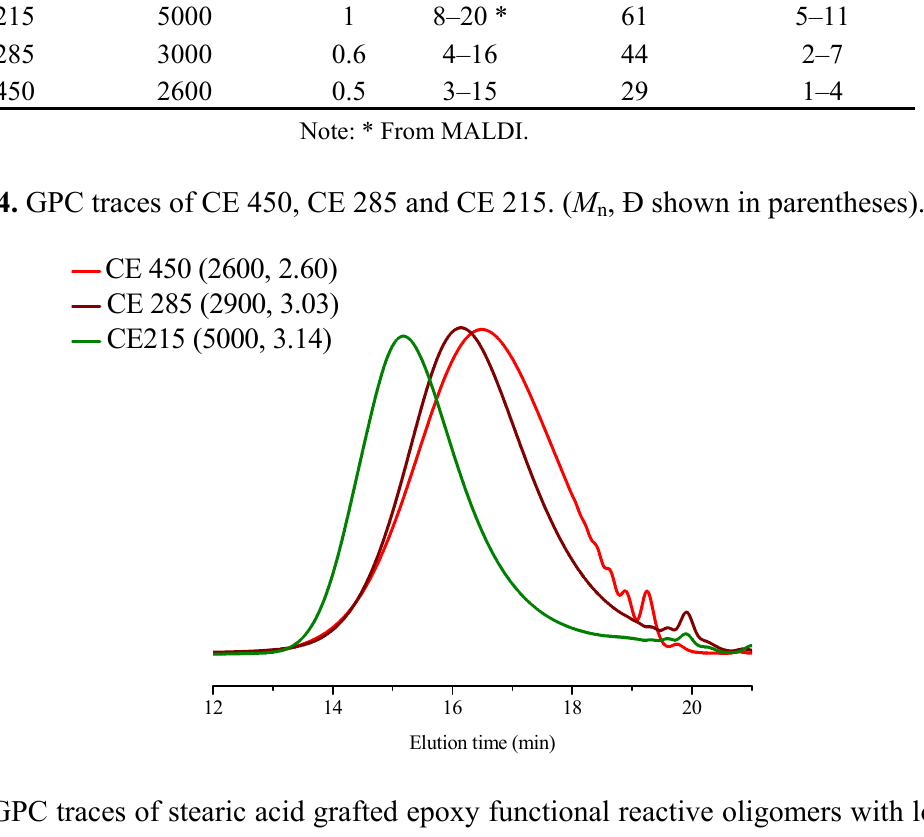
Figure 5. GPC traces of stearic acid grafted epoxy functional reactive oligomers with low, medium and high functionality before and after